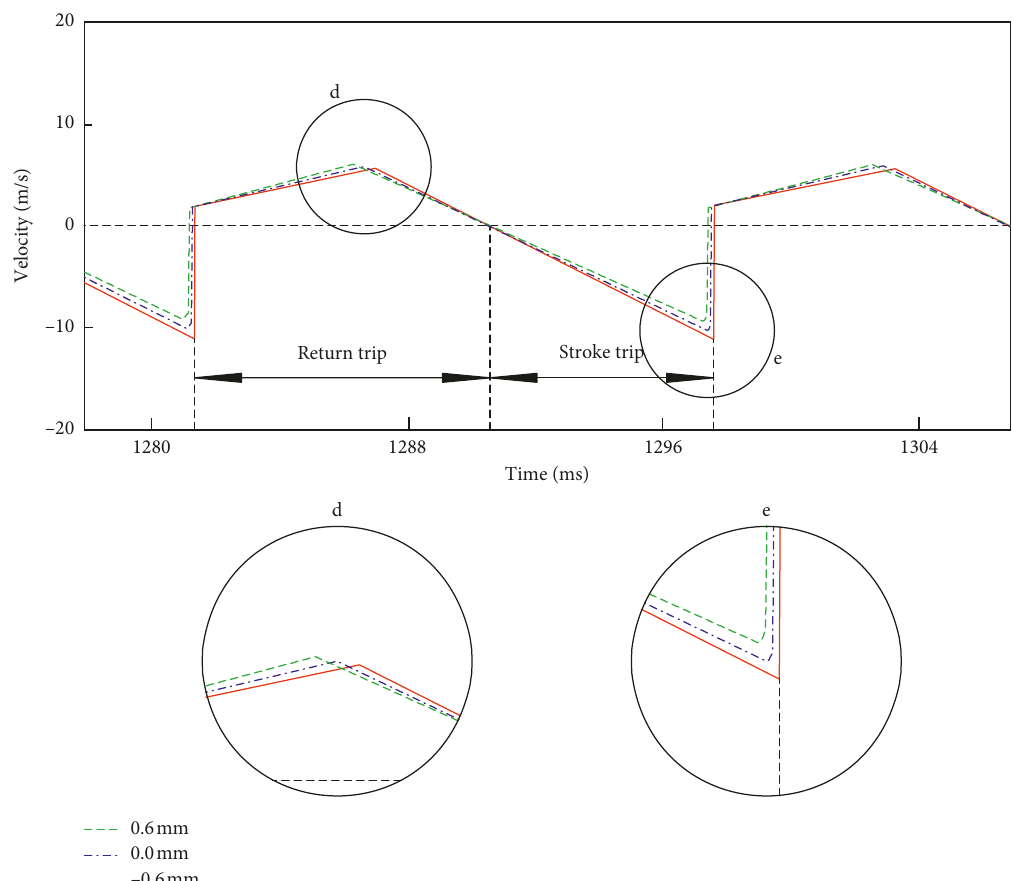
Figure 7: Velocity curves of the impact piston among underlapped, zero, and overlapped reversing valves. Note . d: the amplification of return trip; e: the amplification of stroke trip.